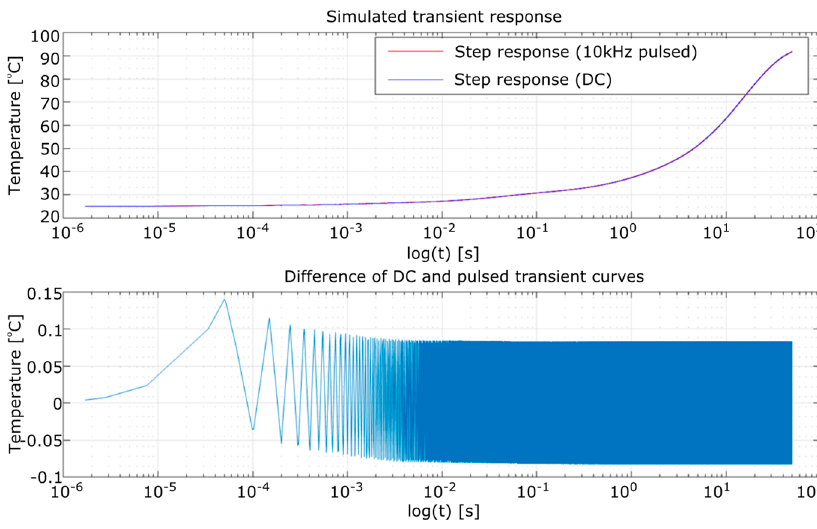
Figure 3. Simulated thermal responses with pulsed and DC driving.